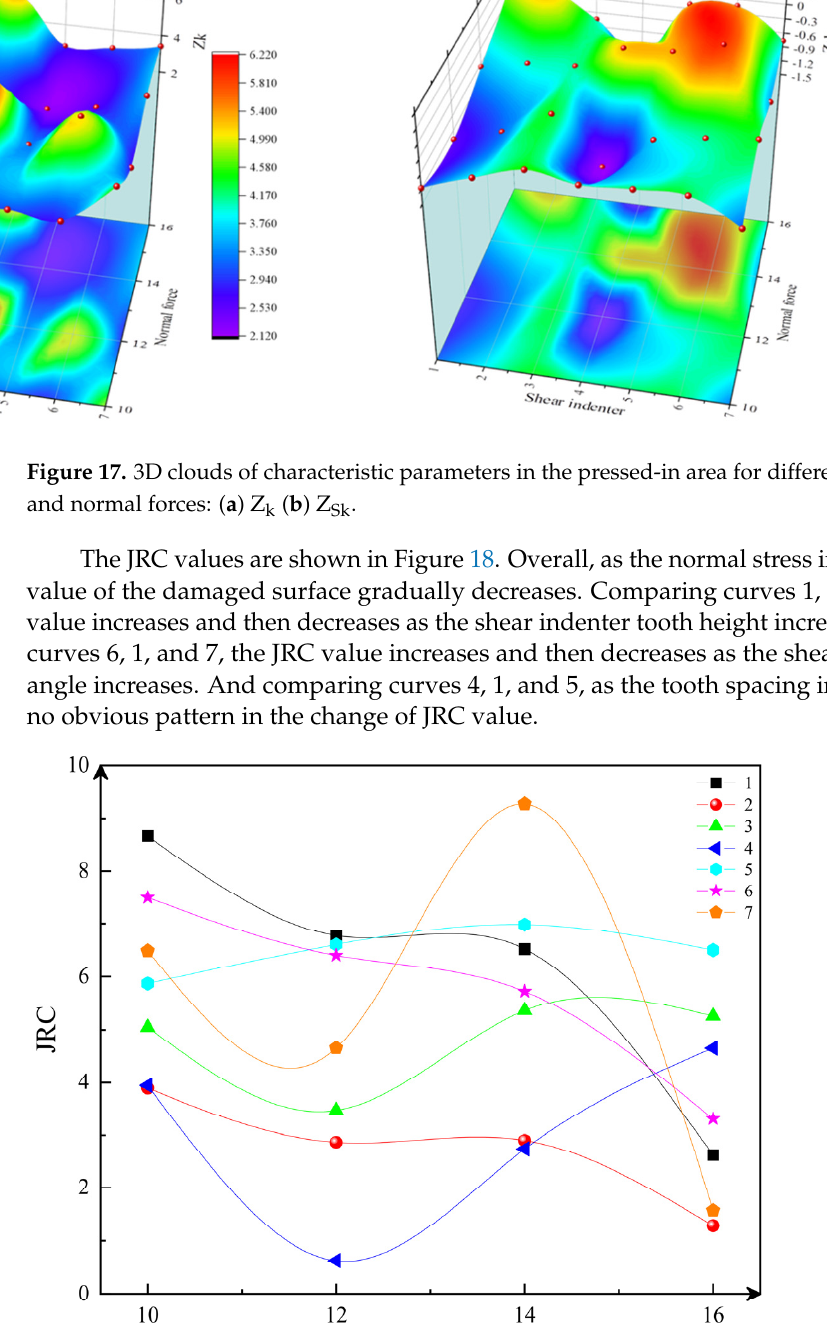
Figure 17. 3D clouds of characteristic parameters in the pressed-in area for different shear indenters and normal forces: ( a ) Z k ( b ) Z Sk.